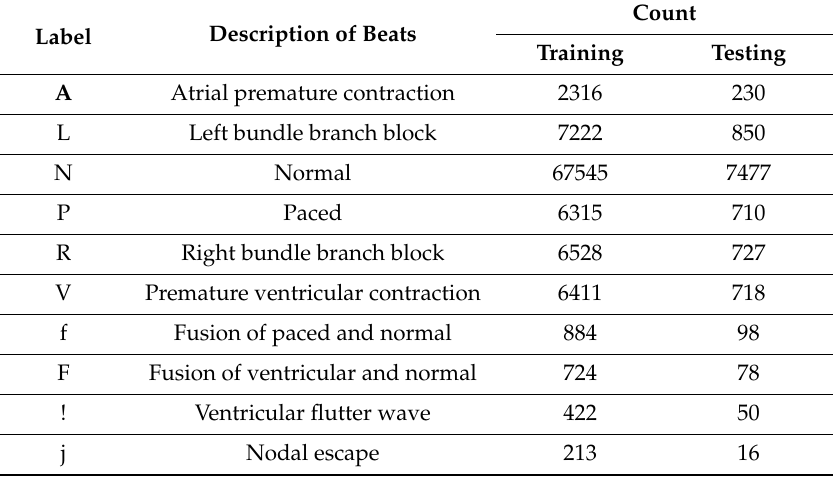
Table 1. The classes of arrhythmia and the number of